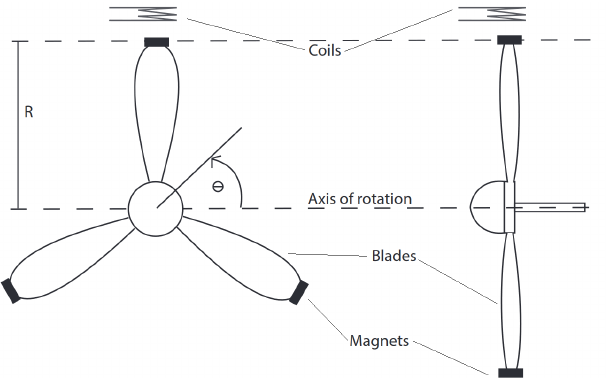
Figure 3. Example of a rotational energy harvester that has the magnets attached to the fan blades [31–33]. In this design, the mass of the magnets at such an extreme radius has a signifi- cant effect on the stability, inertia, and structural integrity of the